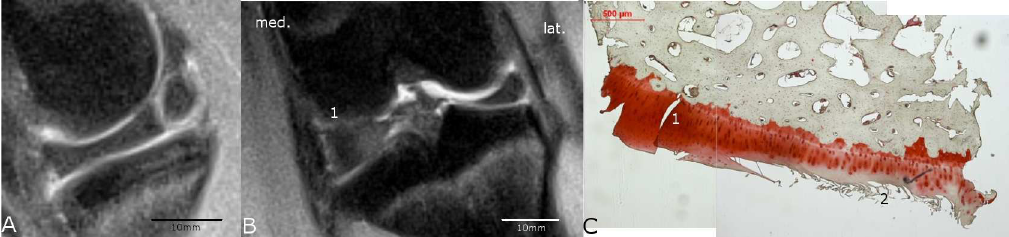
Fig 6. Comparison of MRI (A and B) with histological findings (C). The medial condyle region of the ACLR knee joint of animal #8955 showed in the sagittal MRI-scan (A) through the medial compartment no saliencebut the coronal MRI-scan (B) showed a signal irregularity(1) in the cartilage layer and was therefore rated as pathologically changed. The scale bars for A and B were determined with the program RadiAnt DICOM viewer (see caption Fig 1). The histological safranin-o staining (C) showed a severe degeneration (Little-score: 19.25 points) with a fissure (1) reaching to the subchondral lamellaand severe erosion (2) of the cartilage. Reducedsafranin-ostaining of the remainingcartilage tissue indicated a reduced GAG content and a severe loss of chondrocytes could be seen. The histological and MRI results did